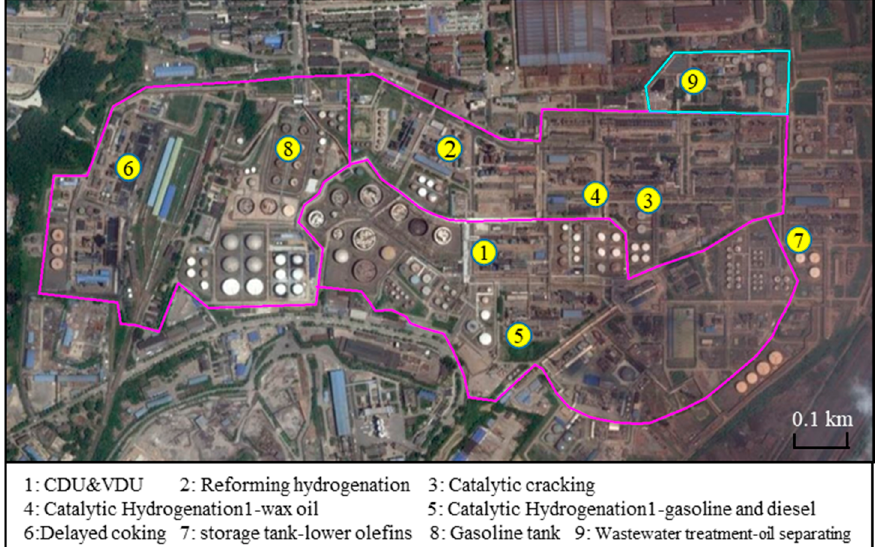
Figure 1. Location of the nine sampling sites in the petroleum plants.